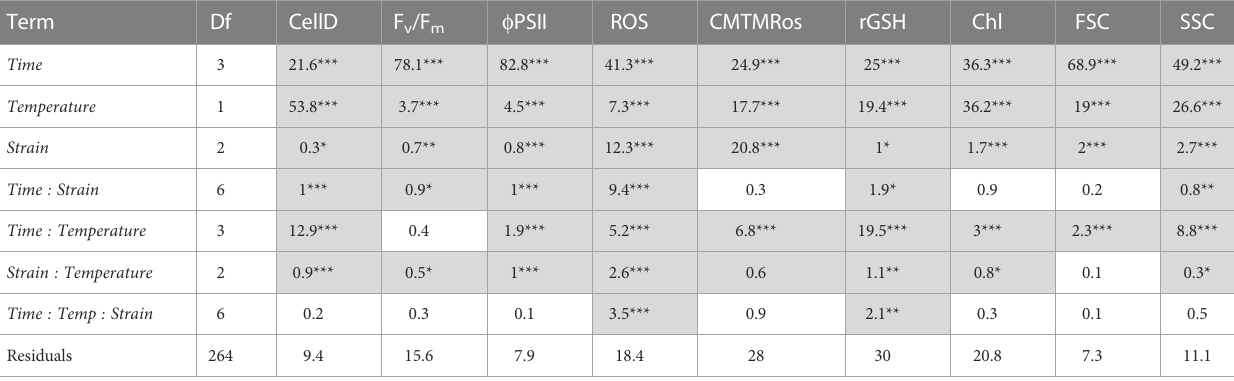
TABLE 2 Analyses of